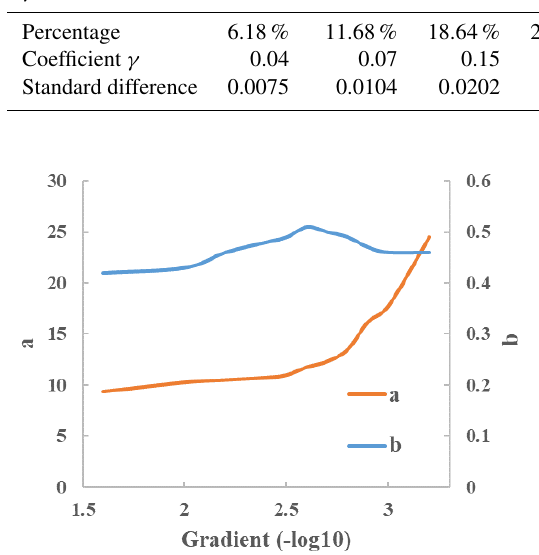
Figure 6. The coefficients a and exponents b of the power scaling relationship predicting maximum river width from upstream cumu- lative runoff (Eq. 1) calculated for different reach gradients. Figure 7. The Spearman rank correlations between our dataset and the GRWL dataset in 111 river regions across